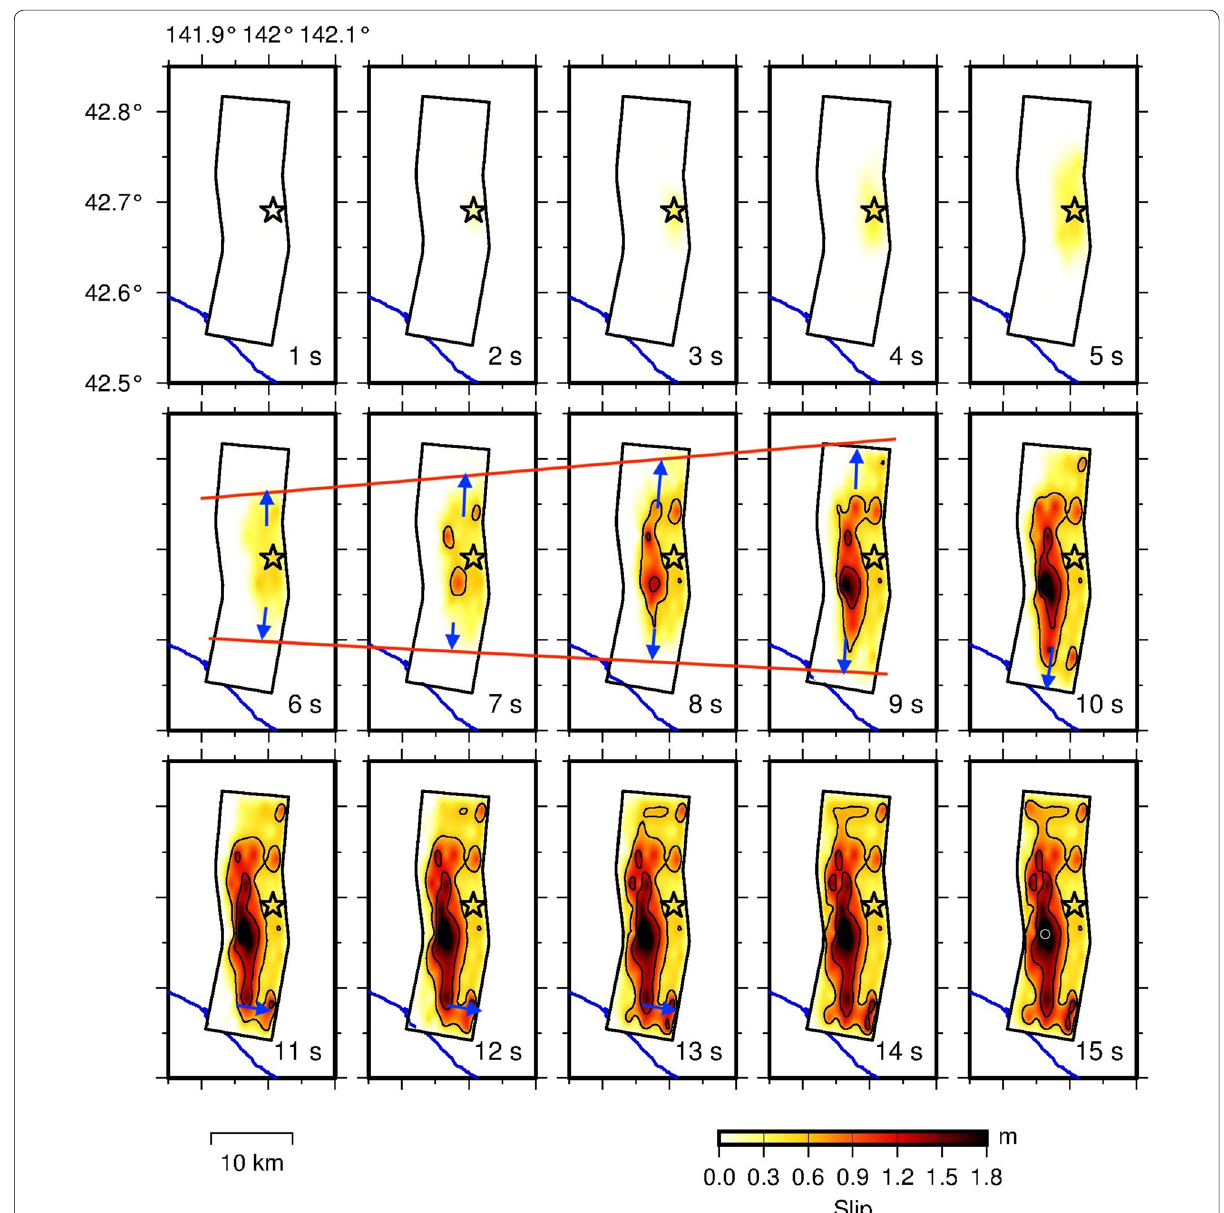
Fig. 6 Snapshot of slip history obtained by kinematic slip inversion (after Asano and Iwata 2019, view from the top). Blue arrows indicate the outline of the rupture propagation. The red lines drawn from t 6 to 9 s, respectively, connect the rupture fronts propagating to north and south; = the larger inclination of the north indicates faster rupture